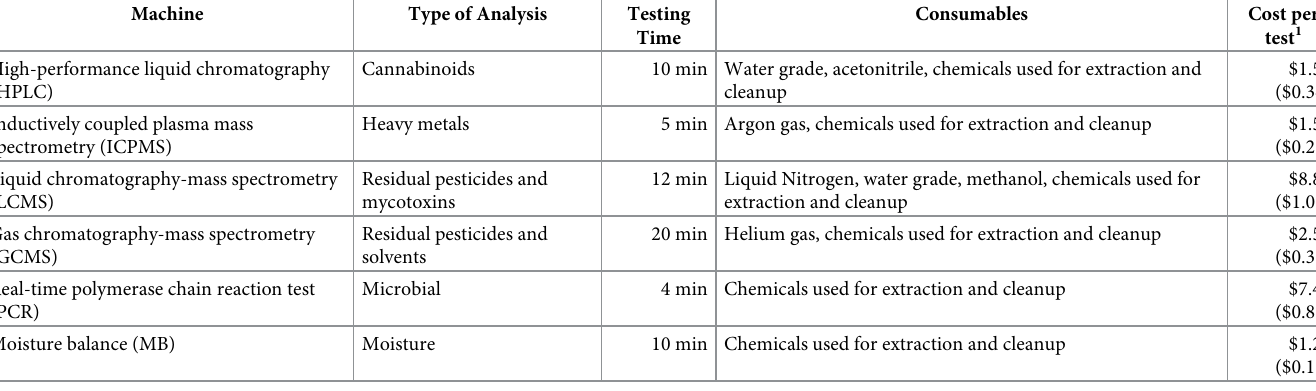
Source: Equipment supplier companies and licensed testing laboratories. 1 Values represent the average cost, with standard deviations in